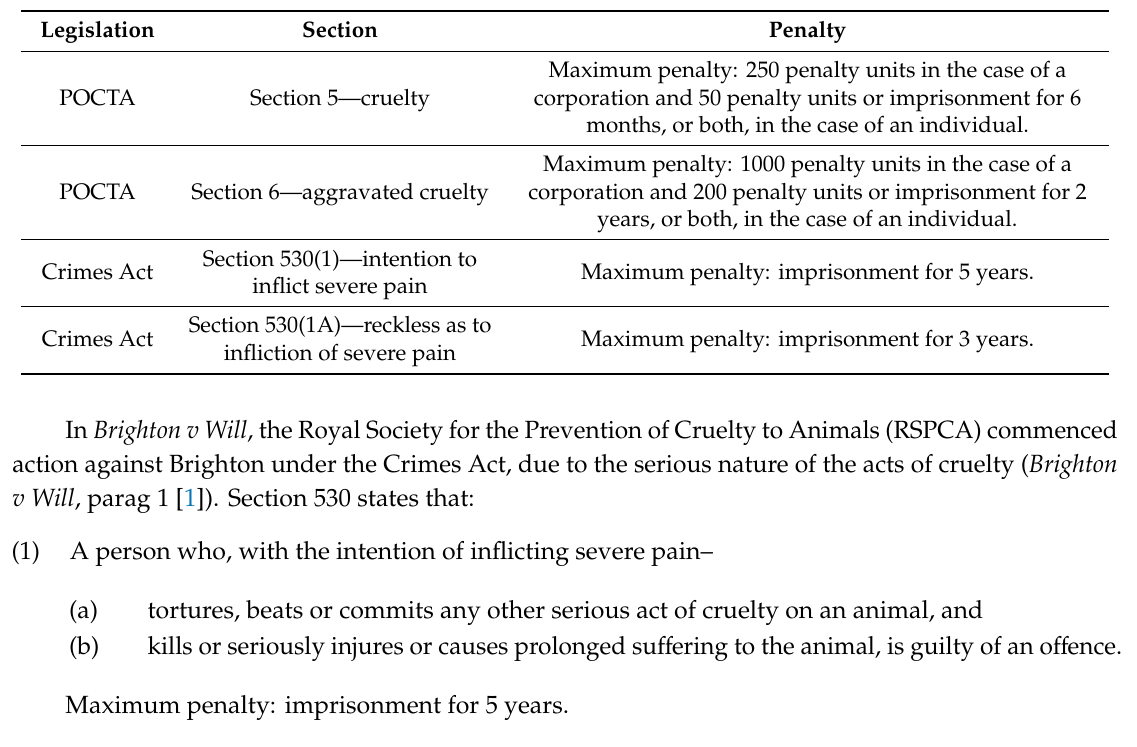
Table 1. Penalties for Animal